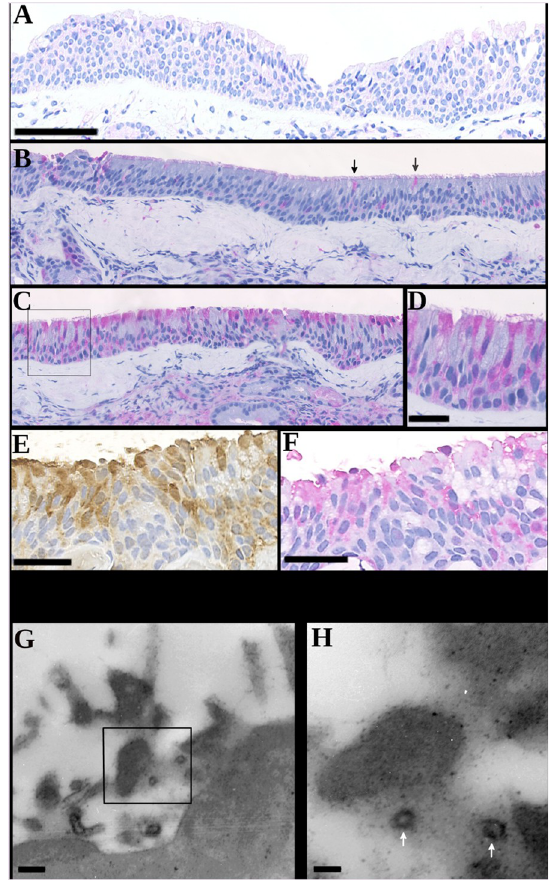
Fig 2. Olfactory biopsies in healthy controls and COVID-19 patients. (A) Healthy control. (B) Patient with low level of infection; arrow indicates the few neurons with an appreciable level of infection. C: Patient with high level of infection. D: Enlargement of a portion of C. E: Neuron immunostaining in the nasal mucosa. F: SARS-CoV-2 immunostaining in a consecutive section of E (A, B, C scale bar 100 μ m, D, E, F scale bar 25 μ m). G: Ultrastructural image of OM biopsy from a COVID-19 patient showing two extracellular SARS-CoV-2 particles in a ciliated cell (bar: 500 nm). H: In the inset, at higher magnification, the black particles show a recognizable SARS-CoV-2 structure (bar: 200